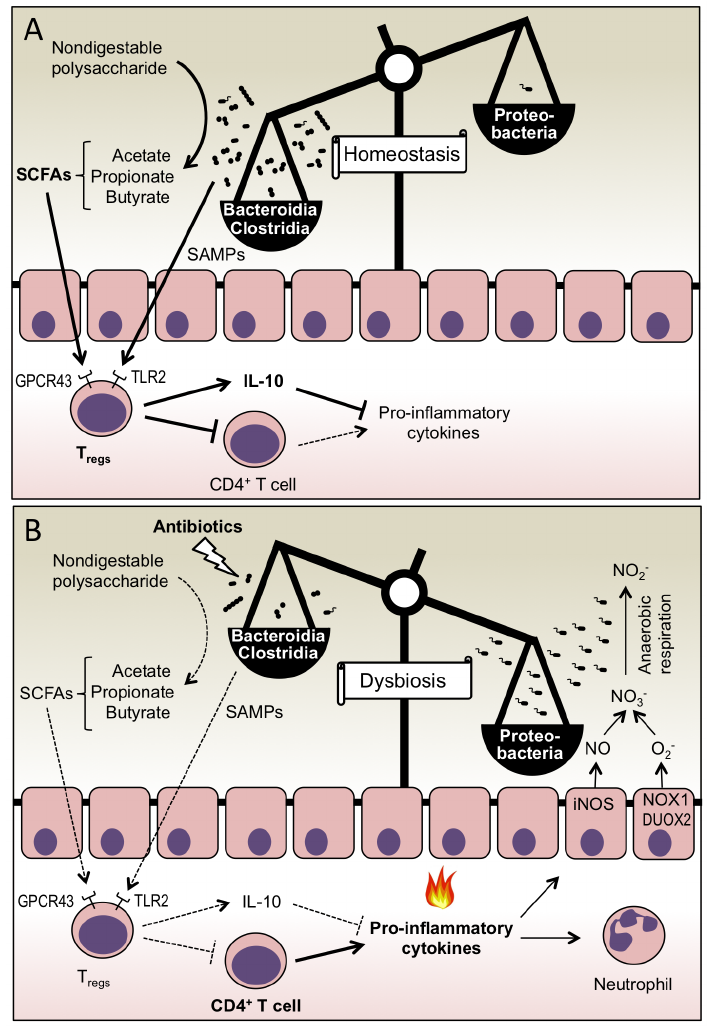
Figure 1. Colonization resistance against Proteobacteria is mediated by host-directed nutritional exclusion. (A) Microbe-host interactions maintain intestinal immune homeostasis. SCFAs and SAMPs produced by obligate anaerobic Clostridia and Bacteroidia stimulate T regs , which suppress inflammation by producing IL-10 and by limiting the expansion of CD4 + effector T cells. (B) Treatment with antibiotics disrupts microbial communities that produce SCFAs and SAMPs. The consequent increase in the inflammatory tone of the intestinal mucosa results in the activation of enzymes, such as iNOS, NADPH oxidase 1 (NOX1), and dual-function NADPH oxidase 2 (DUOX2), which generate reactive nitrogen species (NO) and reactive oxygen species (O 2 2 ). Respiratory electron acceptors (NO 3 2 ) generated as a by-product of the host response support growth of Proteobacteria by anaerobic respiration. The consequent bloom of Proteobacteria leads to an imbalance in the microbial community structure